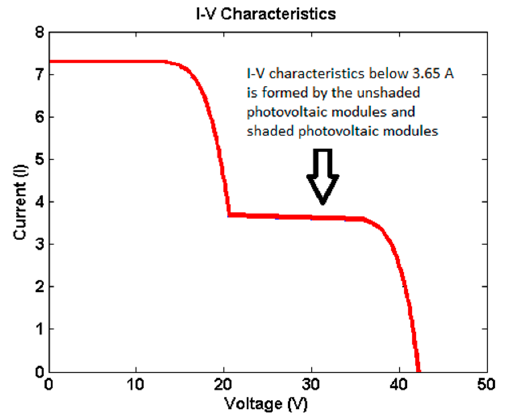
Figure 18. I-V characteristics below 3.65 A—formed by unshaded modules and shaded modules.